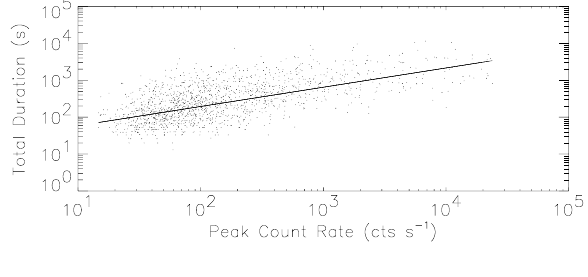
Table6. Characteristicsofthefrequencydistributionsintotaldurations for subgroups of events (see text for details) (2 power-law fits).